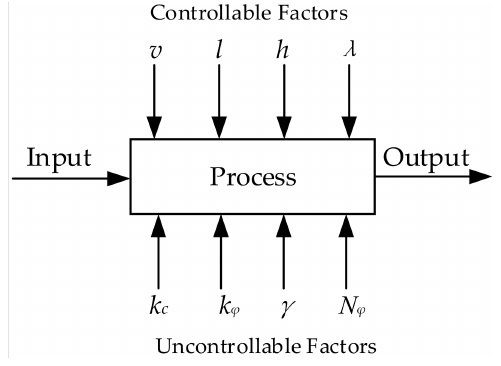
Figure 9. The traction process model.